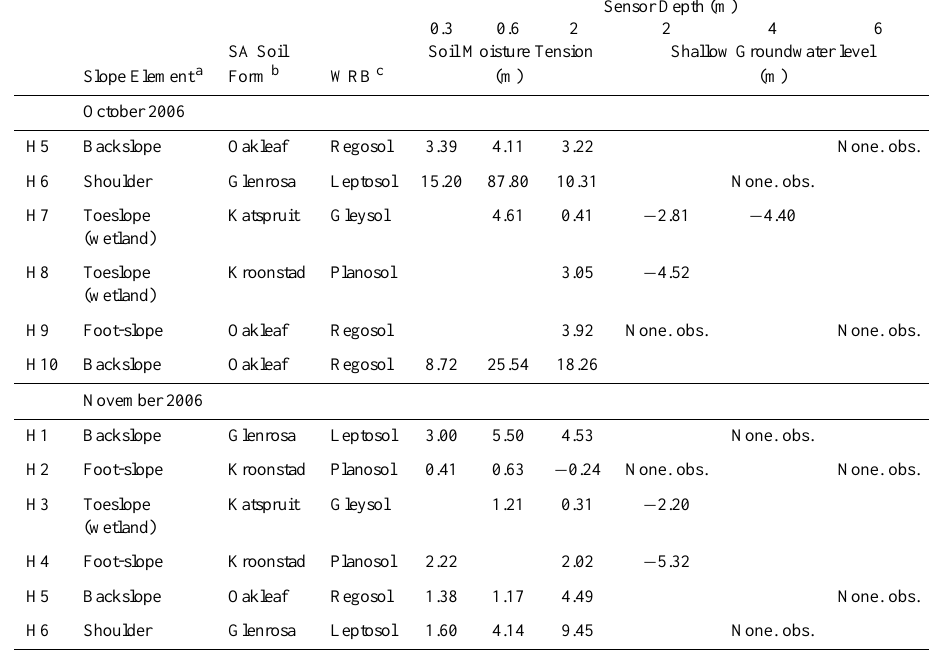
Table 1a. Hydrometry stations in the Manalana catchment with soil form, soil moisture tension and shallow groundwater levels, and soil texture (Soil form and texture data from University of the Free State, unpublished report).